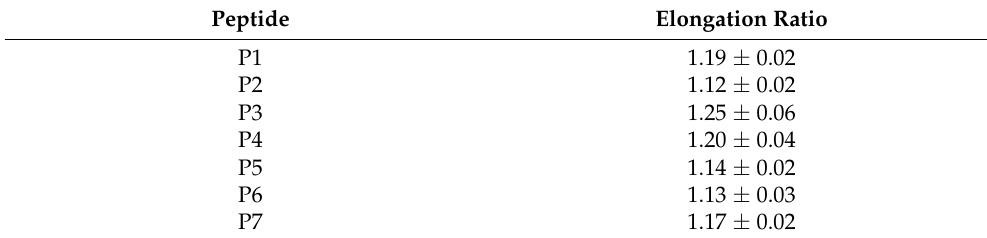
Figure 8. pH-dependence of the average radius of gyration for each peptide studied. All peptides are found to elongate with pH. Some show an essentially linear trend (for example, P2), while others have a pH where there is a distinct “switch” to longer configurations (such as P3). Table 1. Elongation ratios for each peptide.